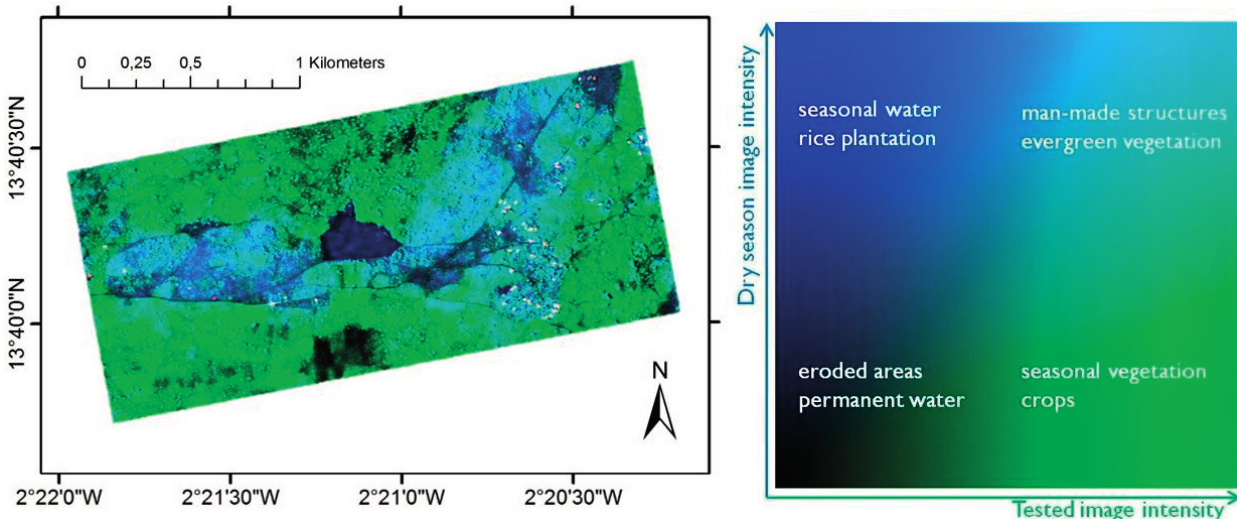
Figure 1. Level-1 α product detail of a small basin near to the Aoérama settlement (test image 31 August